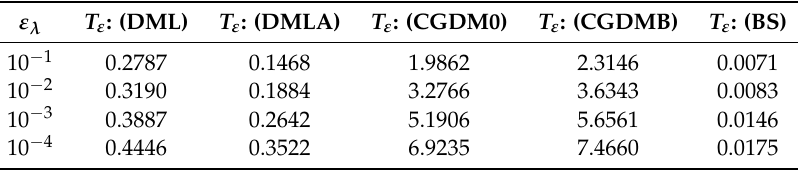
Table 13. Results for Case E with J = 510, m = 25.